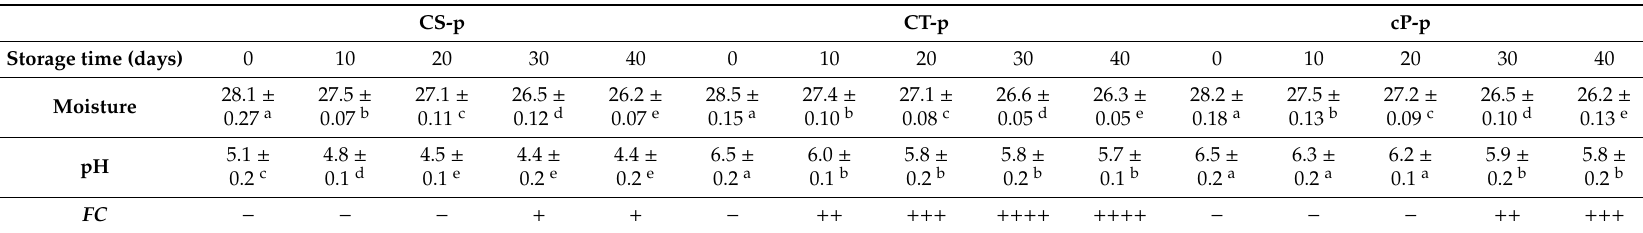
Table 6. Fungal contamination of the fresh pasta inoculated with Penicillium roqueforti DPPMAF1 during a 40-day storage period at 4 ◦ C. CS-p, semolina fresh pasta fortified with the chickpea sourdough; CT-p, conventional semolina fresh pasta; CT-p, cP-p semolina fresh pasta added to 0.3% (w / w on a flour weight basis) calcium propionate. The pH and moisture are also